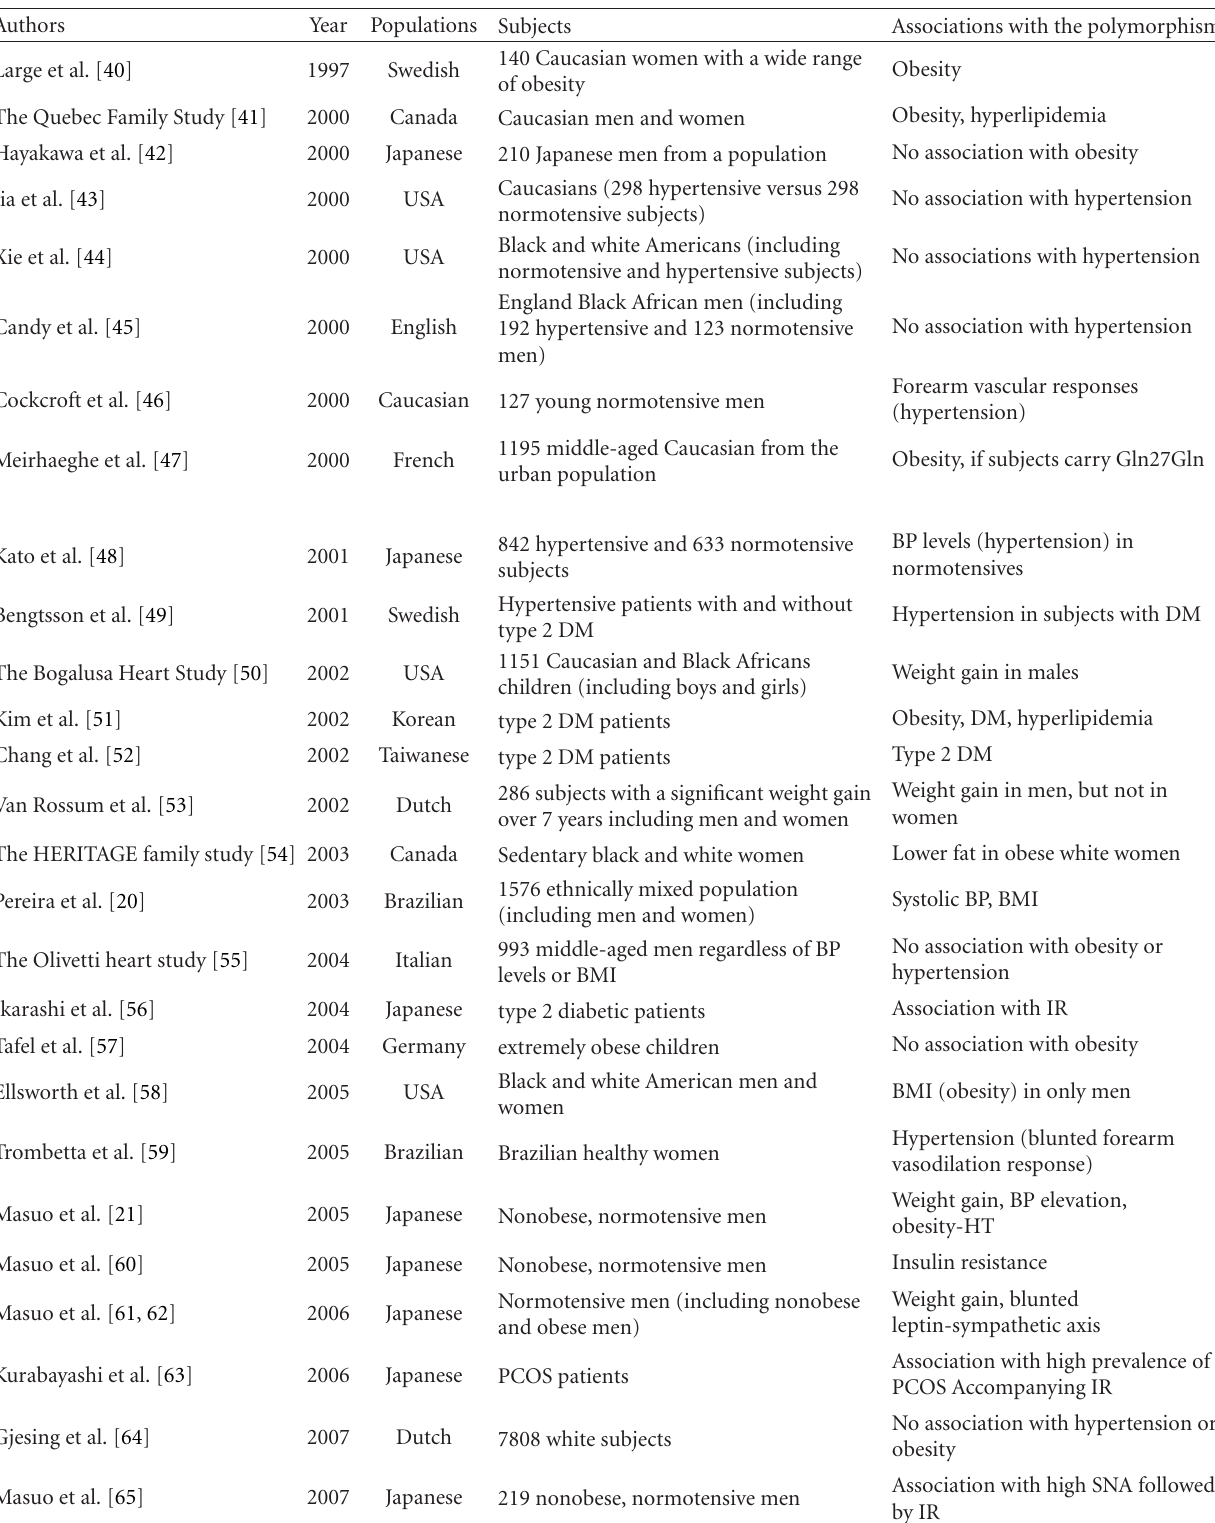
Table 2: Arg16Gly, β 2-adrenoceptor polymorphisms: association with hypertension, metabolic syndrome (type2 diabetes: (DM)), and